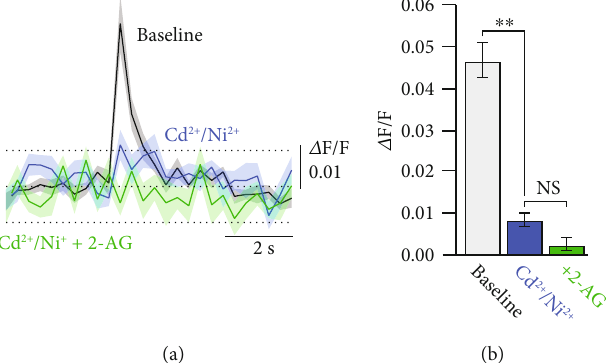
Figure 8: Block of VDCCs does not uncover preNMDAR-dependent Ca 2+ transients. (a) Axonal Ca 2+ transients evoked by a single AP in a spiny stellate axon recorded in L2/3 during baseline (black) and in the presence of the VDCC blockers Cd 2+ and Ni + (blue). Subsequent bath application of 2-AG did not result in an AP-evoked Ca 2+ transient (green). Shaded areas represent ± SEM and dashed lines ± SD of the basal fl uorescence before stimulation. (b) Bar graph summary of the peak Ca 2+ transient amplitudes in the di ff erent conditions ( n = 4 ). ∗∗ p < 0 : 01 by Student ’ s paired t -test with Bonferroni correction for multiple comparisons. All data are represented as mean ± SEM